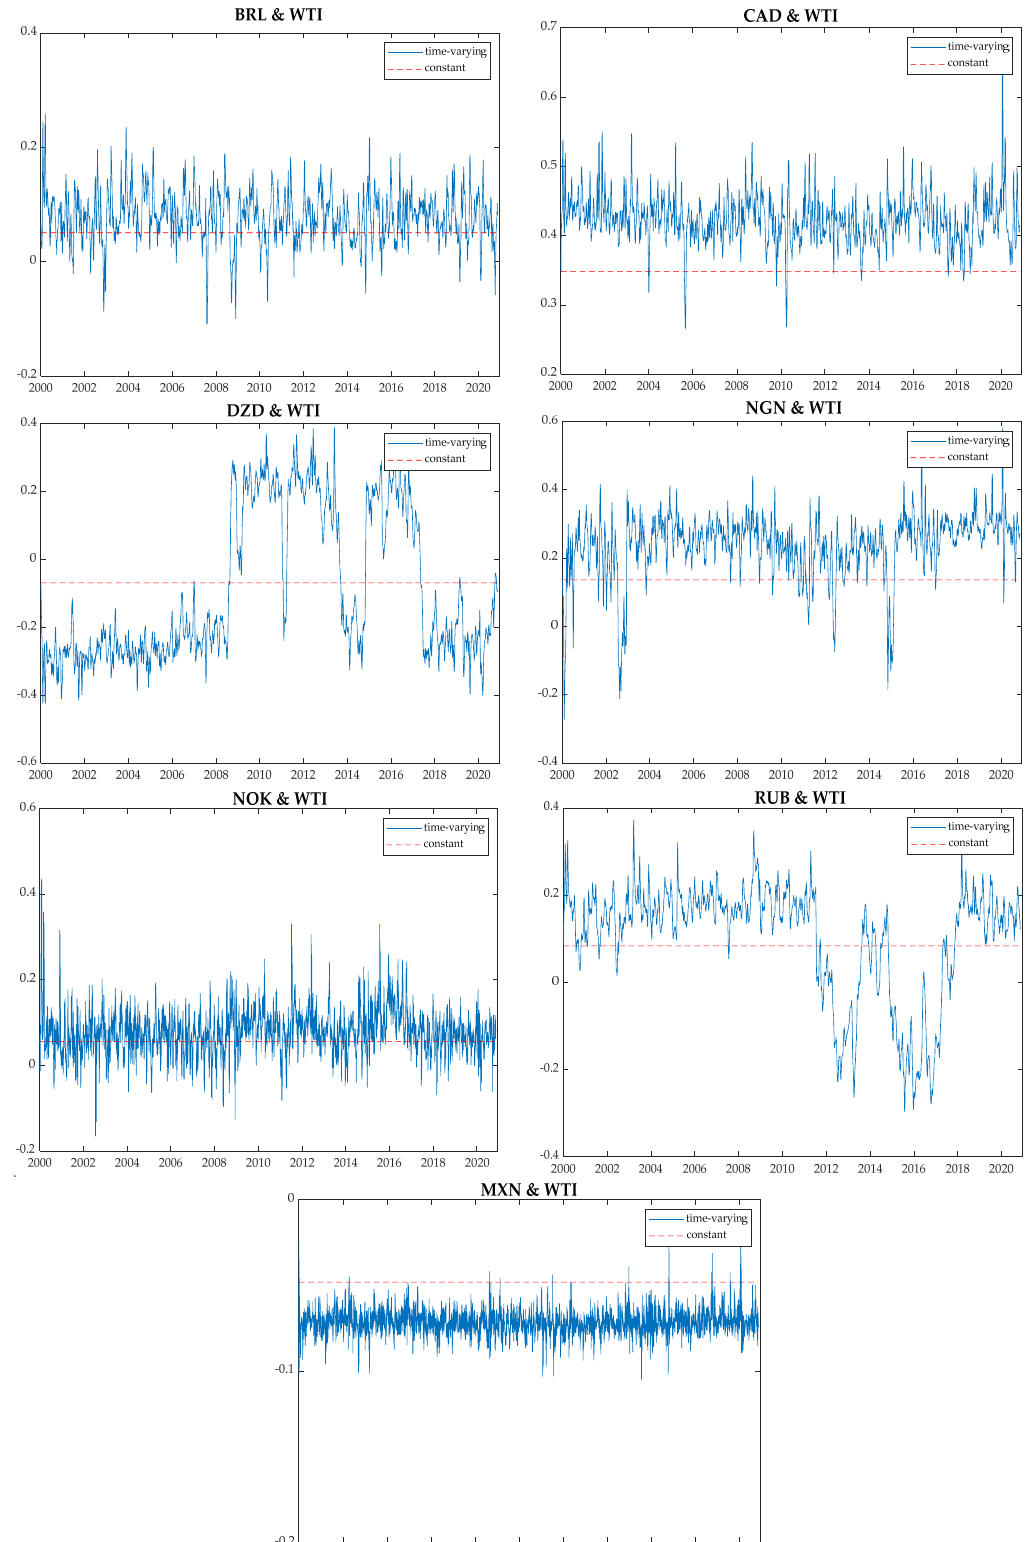
Figure 5. Time-varying dependence degree among the crude oil and exchange rates of oil exporters. Note: the vertical coordinates correspond to dynamic Kendall coefficients between crude oil and exchange rate returns of each oil exporter.